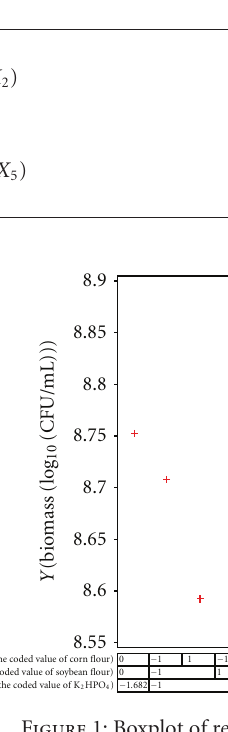
Figure 1: Boxplot of results of the central composite